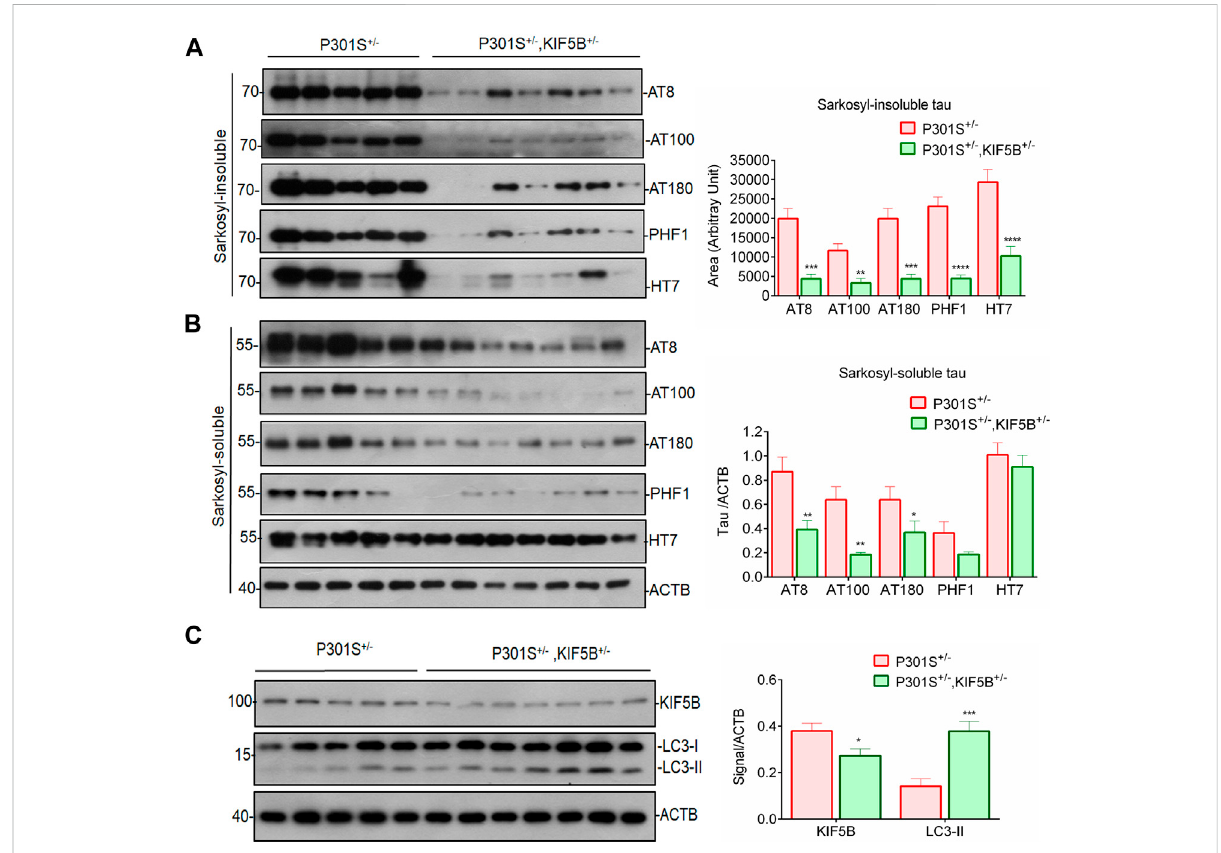
FIGURE 8 Depletion of KIF5B reduces insoluble tau accumulation in the brain of tau mice. Western blots showed phosphorylated forms of tau (AT8, AT180, AT100, PHF1) and total tau (HT7) in sarkosyl-insoluble (A) and insoluble (B) fractions after sarkosyl extraction from the whole brain lysates of P301S +/ − and P301S +/ − ,KIF5B +/ − at 8-month-old mice. (C) KIF5B reduction also increased the level of LC3-II protein, an autophagic marker, in the whole brain lysate of P301S +/ − ,KIF5B +/ − . ACTB was used as an internal control. Values represent group mean ± SEM and n = 10 – 14 mice